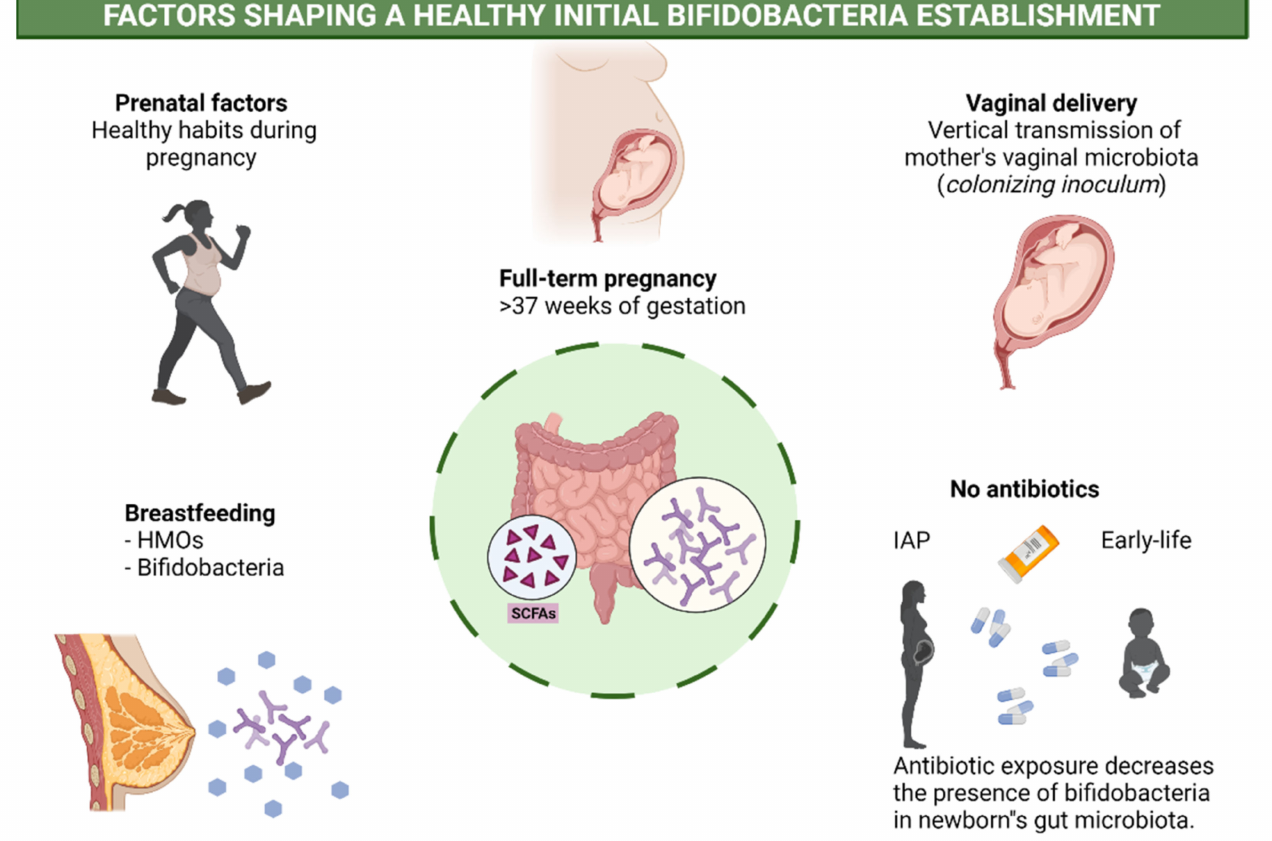
Figure 1. Factors shaping healthy initial bifidobacteria